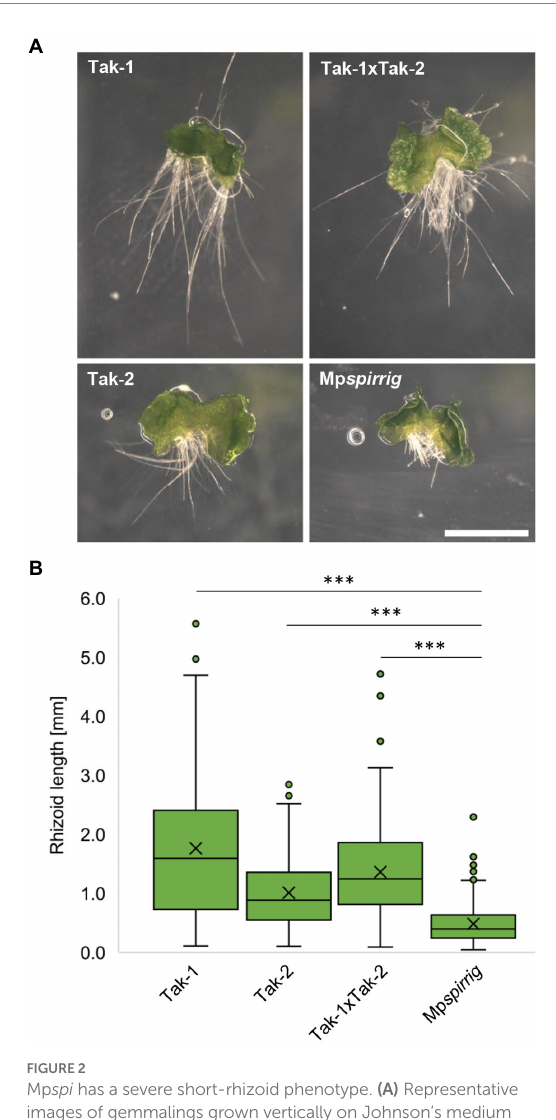
FIGURE 2 Mp spi has a severe short-rhizoid phenotype. (A) Representative images of gemmalings grown vertically on Johnson‘s medium for 7 days. Scale bar: 2 mm. (B) Rhizoid length of seven-day-old gemmalings. N ≥ 240. Significance was tested by ANOVA at p ≤ 0.001 ( *** ).